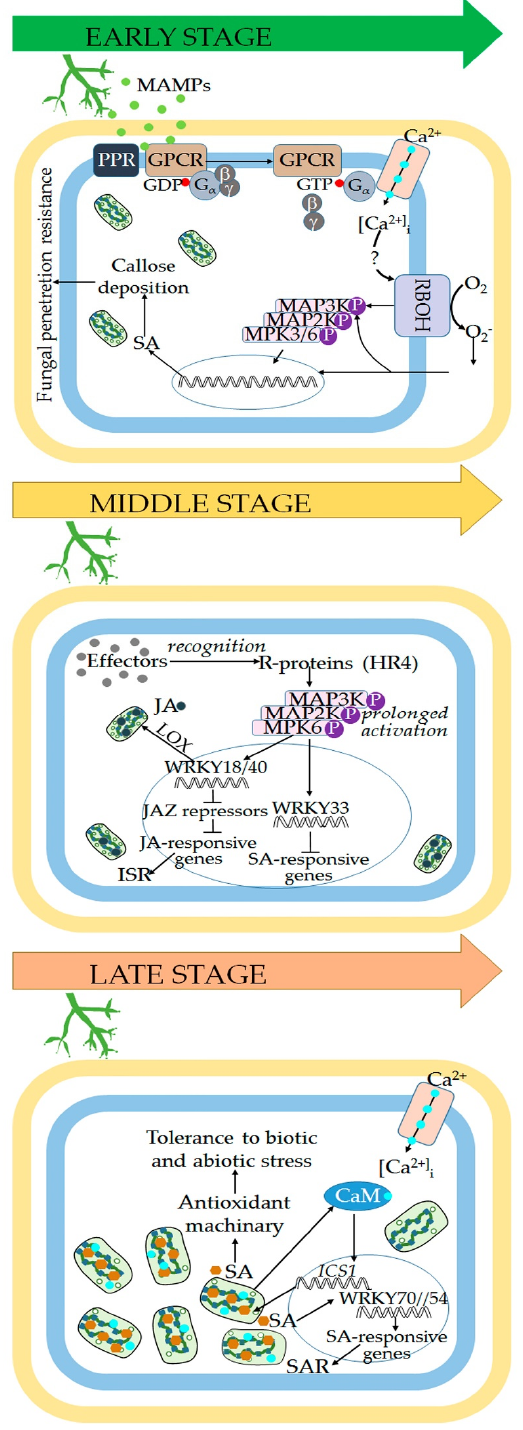
Figure 1. Mechanism of plant responses according to the time of interaction with Trichoderma . The model is divided into three stages. The earlier stage comprises the first hours of interaction, wherein the plant is avoiding fungal root colonization due to SA phytohormone and consequently the callose deposition. This first stage is initiated by the recognition of MAMPs secreted by Trichoderma ,